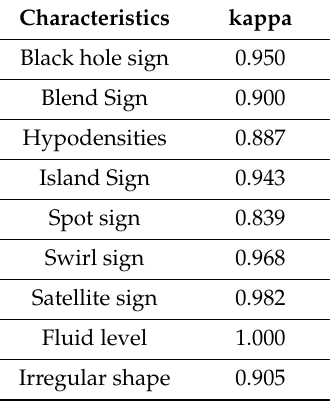
Table 2. Interrater Agreement for non-contrast computed tomography (NCCT) markers and computed tomographic angiography (CTA) spot